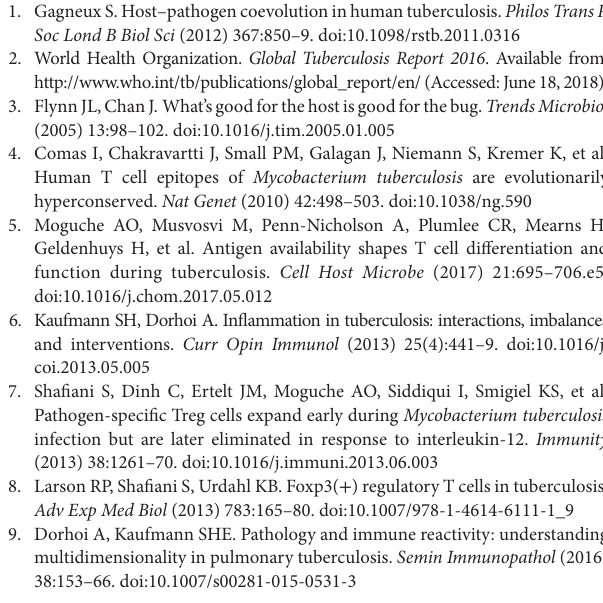
FigUre s1 | Gating strategy of Broncho alveolar lavage, left (red box) cells and peripheral blood mononuclear cells, right (black box). Lymphocytes, singlets were gated based on FSC and SSC, followed by a CD3-positive gate (top panel). CD3 + cells were subdivided into CD4 or CD8 positive cells, and stained for CXCR3 high (bottom center), and CD26 high (bottom right). FigUre s2 | Quantitative assessment of immunohistochemistry. Scores were assigned taking into consideration the proportion of positive cells on a scale of 0–4: score 0, no staining; score 1, from “0 to 10%” positive cells; score 2, from “11 to 30%” positive cells; score 3, from “31 to 70%” positive cells; score 4, if “ > 70%” positive